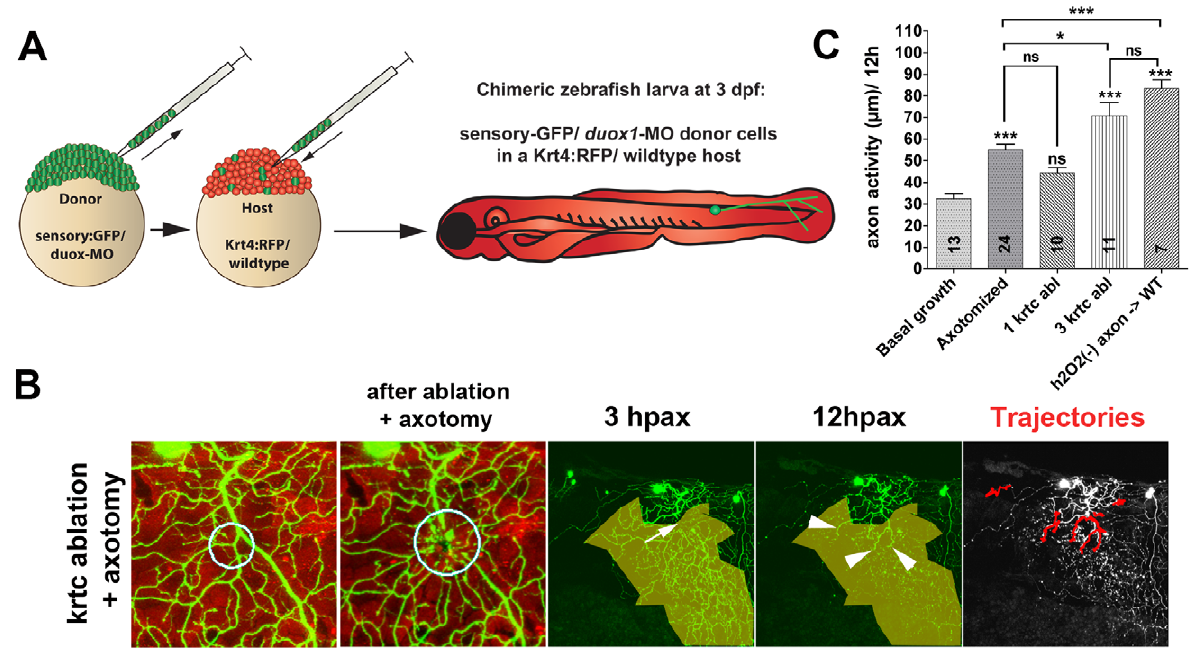
Figure 7. H 2 O 2 produced by damaged keratinocytes is sufficient to promote axon regeneration. (A) Diagram of the procedure for creating chimeric larvae to test where Duox1 functions to promote axon regeneration: cells from a duox1 -MO injected sensory:GFP transgenic donor were transplanted into a wildtype Krt4:RFP transgenic host. GFP-labeled Rohon-Beard sensory neurons were thus deficient in Duox1 function, while RFP-labeled keratinocytes were wildtype. (B) Ablation of $ 3 wildtype keratinocytes (circle) and axotomy of a nearby duox1 -morphant RB axon in the upper trunk region (arrow) promoted regeneration of severed axon branches (arrowheads) and reinnervation of denervated territory (shaded area) (see also Video S9). (C) Quantification of axon activity in chimeric embryos after keratinocyte ablation and axotomy, compared to basal growth (same as in Figure 1E), axotomy alone (same as in Figure 3D), and keratinocyte ablation (same as in Figure 4E). Sample size for each group is indicated by the numbers in the bars. Error bars represent the standard error of the mean. For statistical analyses, we performed one-way ANOVA and either Dunnett’s post-test to compare individual groups to controls (asterisks above bars indicate significance compared to control, the first column in graph) or Bonferroni’s post-test to compare individual groups with each other (as indicated by brackets, p = ns . 0.05, * p , 0.05, *** p ,